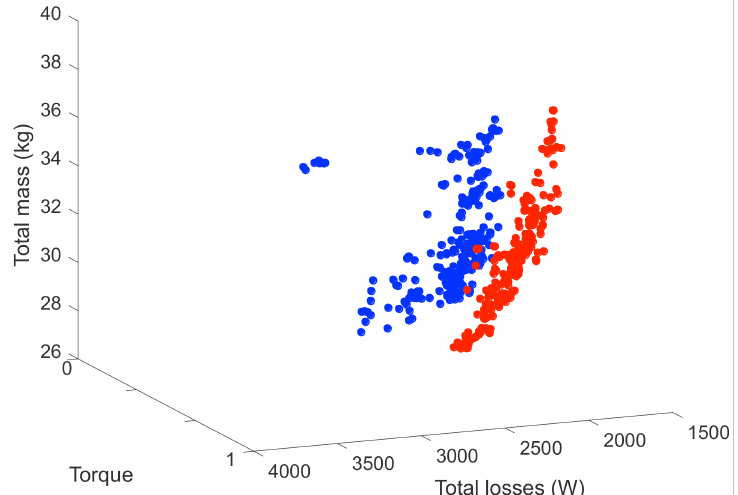
Figure 17. Pareto Front comparison: “abc model” vs. “dq